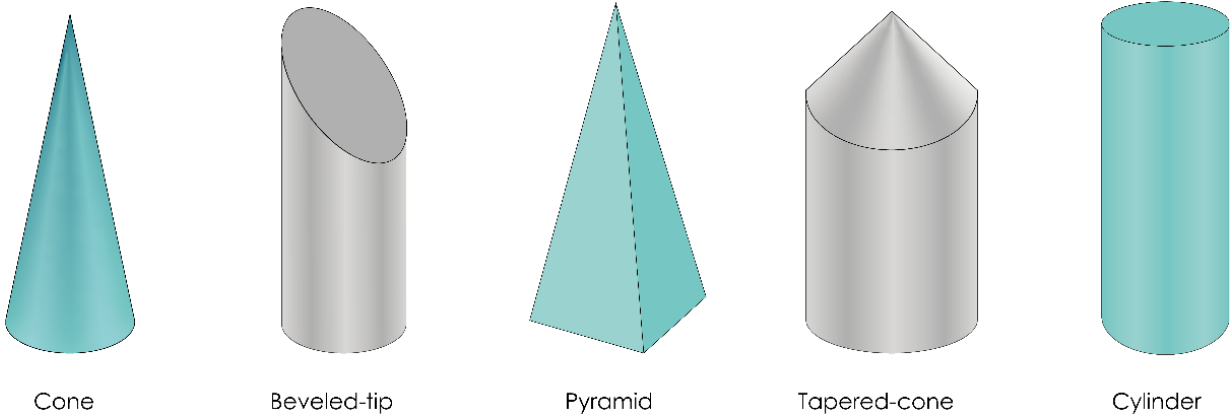
Figure 8. Different shapes of microneedles obtained by 3D printing technologies. The image was created with Adobe Illustrator CC (Version 23.0.1.; Adobe Inc., San Jose, CA, USA, 2019).